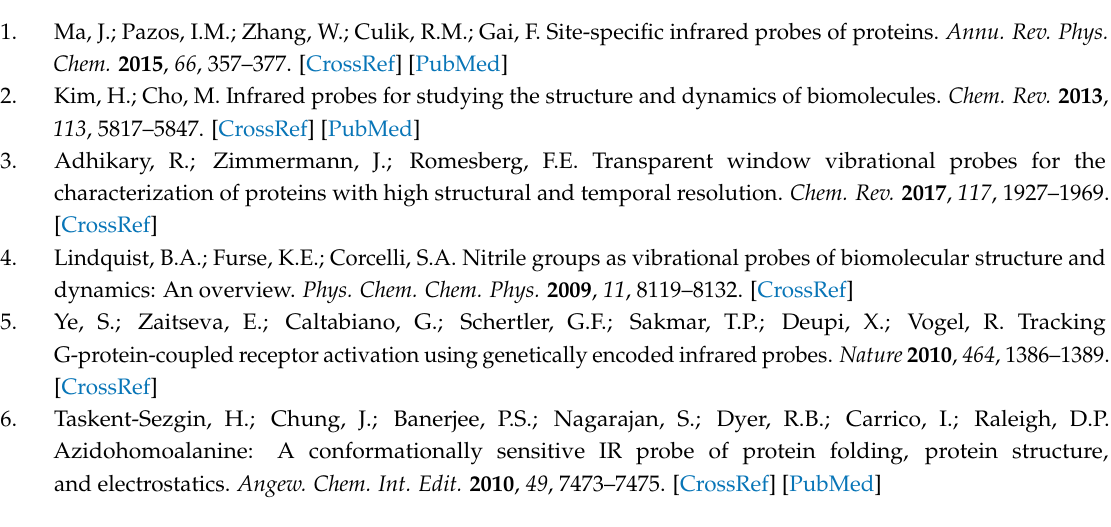
Supplementary Materials: The following are available online. Figure S1: The NC stretching frequencies of 5ICI versus solvent parameter α or β . Only frequencies obtained in protic solvents ( α (cid:54) = 0) were used, Figure S2: The NC stretching frequencies of 5ICI versus solvent parameter π * or β . Only frequencies obtained in aprotic solvents ( α = 0) were used, Figure S3: NC stretching frequencies of 5ICI in various solvents versus Kamlet–Taft empirical parameter π *, β , or α , Figure S4: The NC stretching frequencies of NM5ICI versus the density of hydrogen-bond donor groups in solvents (R 2 = 0.99), Figure S5: The NC stretching frequencies of H-bonded NC group versus Kamlet-Taft empirical parameter π *, β , or α . Only frequencies obtained in protic solvents ( α (cid:54) = 0) were used, Figure S6: The NC stretching frequencies of H-bonded NC group versus the density of hydrogen-bond donors of solvents, Figure S7: The NC stretching vibration of NM5ICI in selected